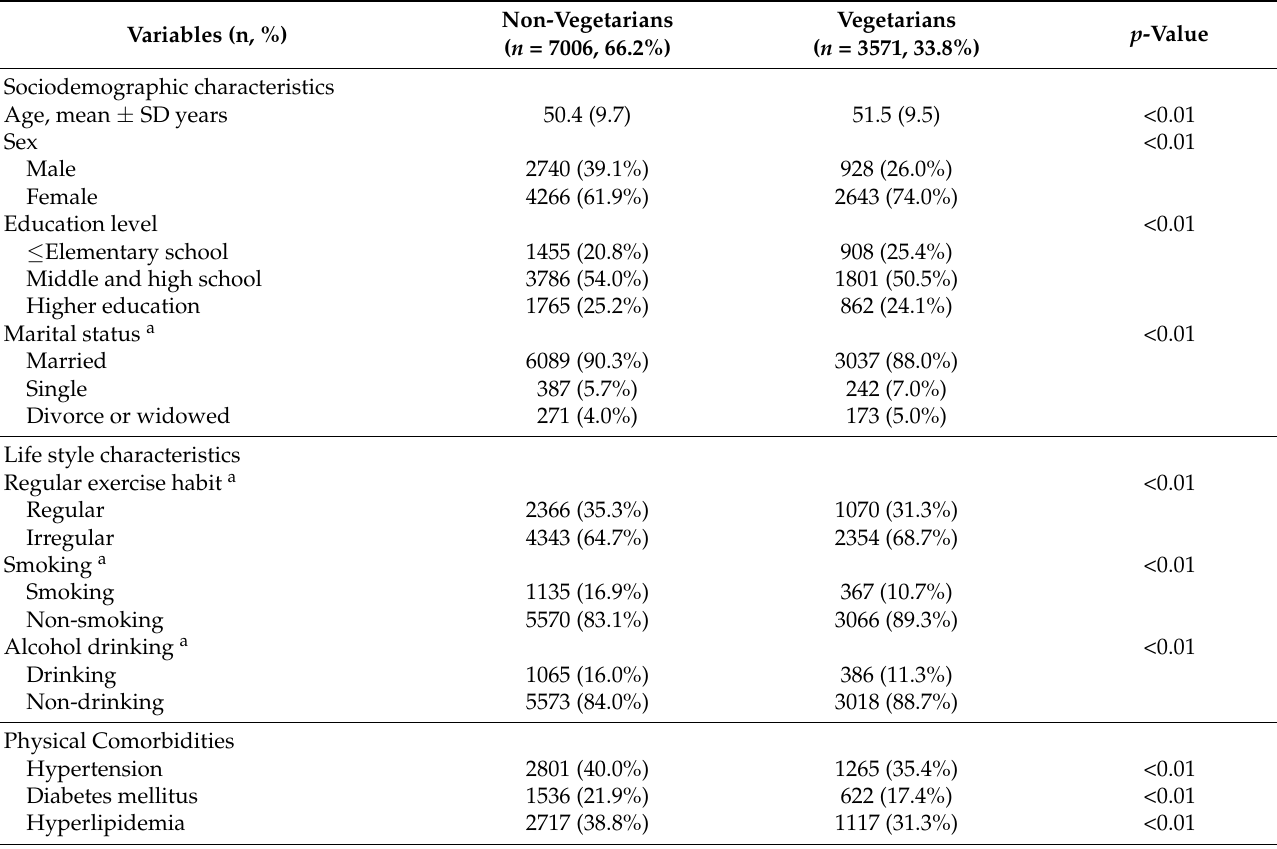
Table 1. Socio-demographic characteristics and physical comorbidities of vegetarians and non-vegetarians.